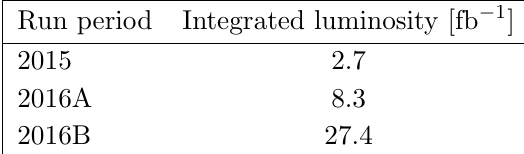
Table 1 . The data-taking periods and the corresponding integrated